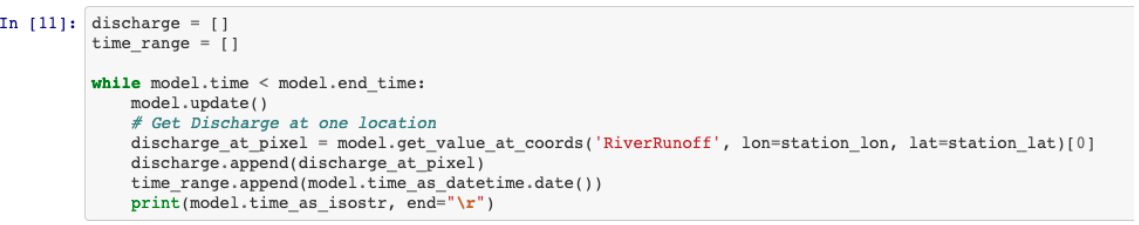
Figure 8. Snippet from the code that generated the hydrographs of Fig. 7 showing how much this looks like the code of Fig. 6 despite the models involved being far more complex. This shows that the user of the eWaterCycle platform can work with different and complex models from the same